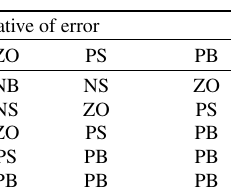
Table 1 FLC rule base used in FES